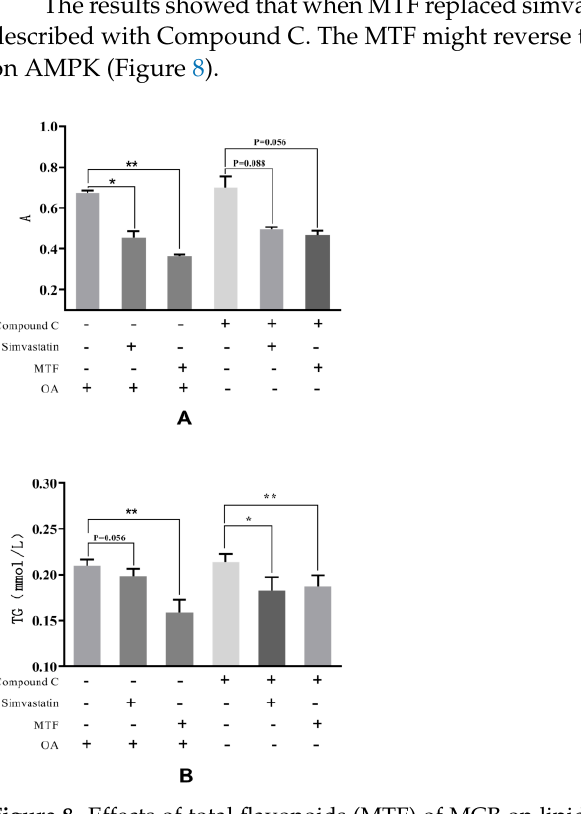
Figure 8. Effects of total flavonoids (MTF) of MCB on lipid accumulation in HepG2 cells. ( A ) the absorbance of lipid accumulation was measured by oil red O staining. ( B ) changes of TG content. “*” indicates p < 0.05 and “**” indicates p <